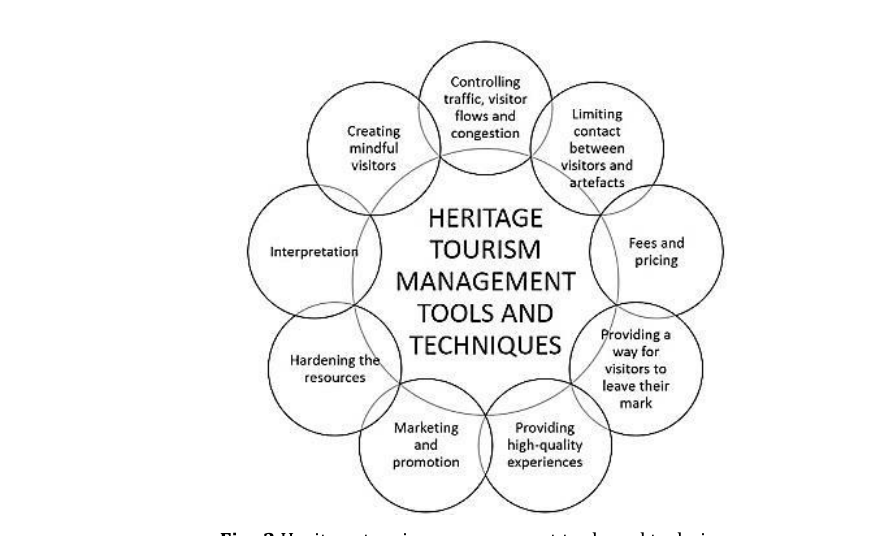
Fig. 2 Heritage tourism management tools and